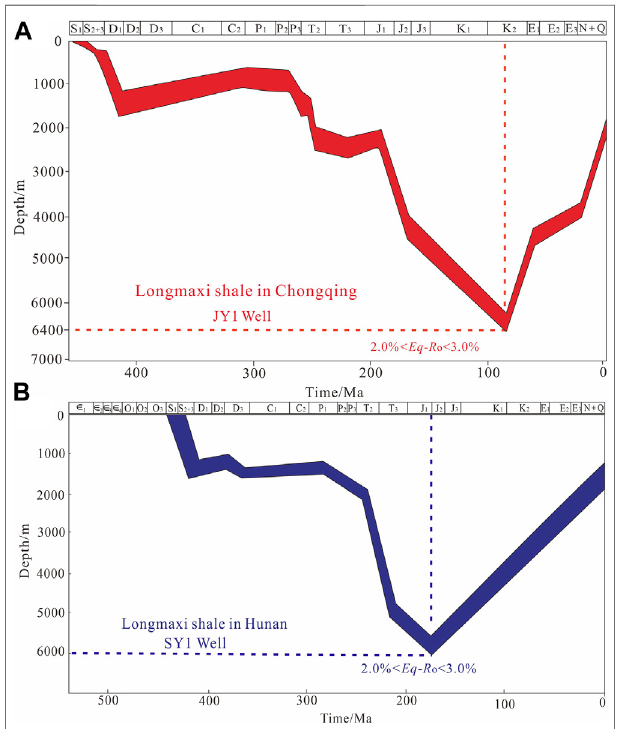
FIGURE9 |(A) Burial historyofthe Longmaxi shale in Chongqingbased on JY1 well, revised from Jin et al. (2018). (B) Burial history of the Longmaxi shale in Hunan based on SY1 well, revised from Wan et al. (2017).